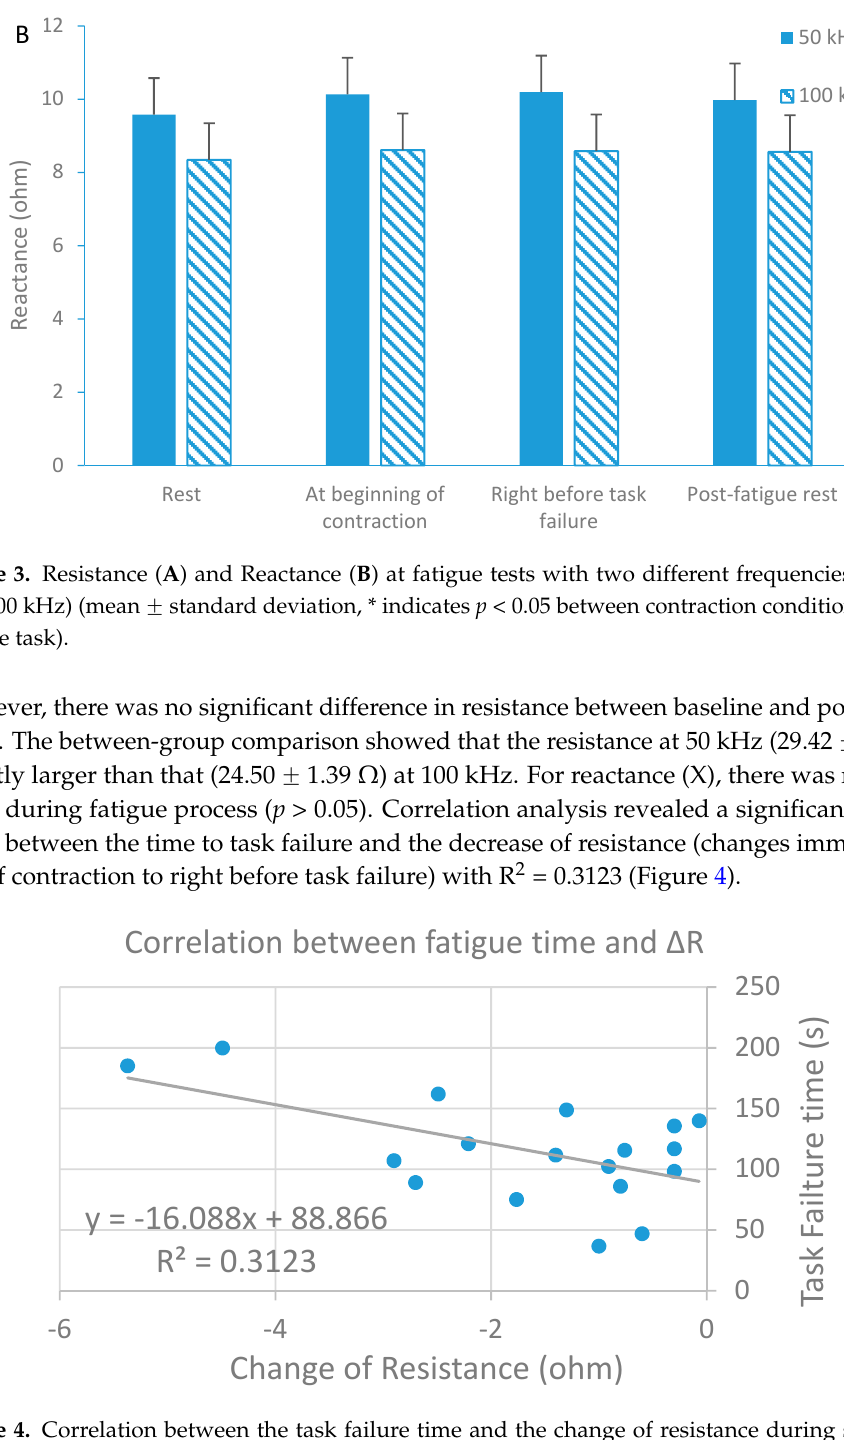
Figure 4. Correlation between the task failure time and the change of resistance during sustained contraction in fatigue test ( p = 0.0159).